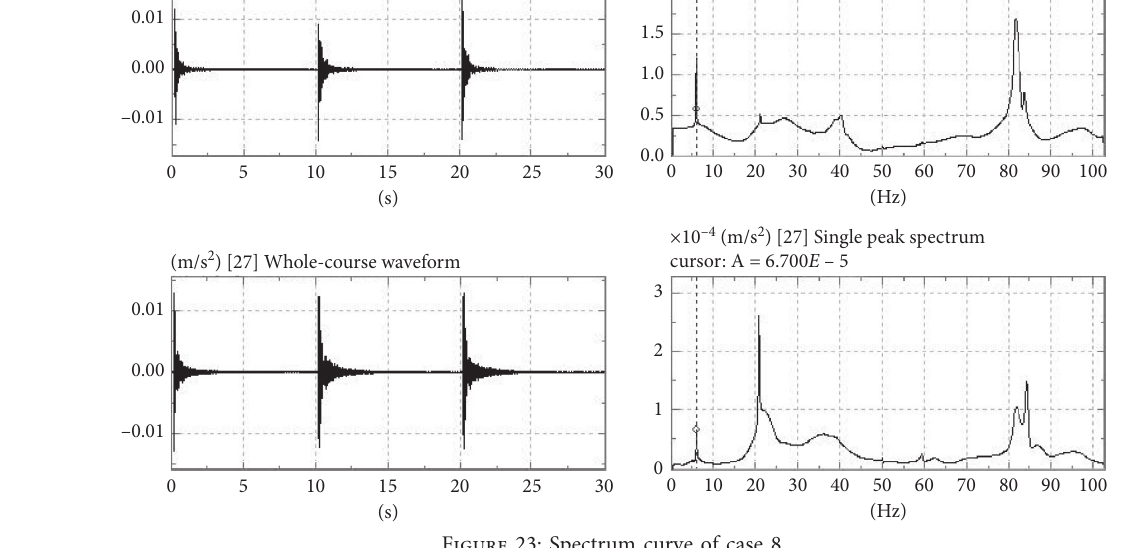
Figure 23: Spectrum curve of case 8.